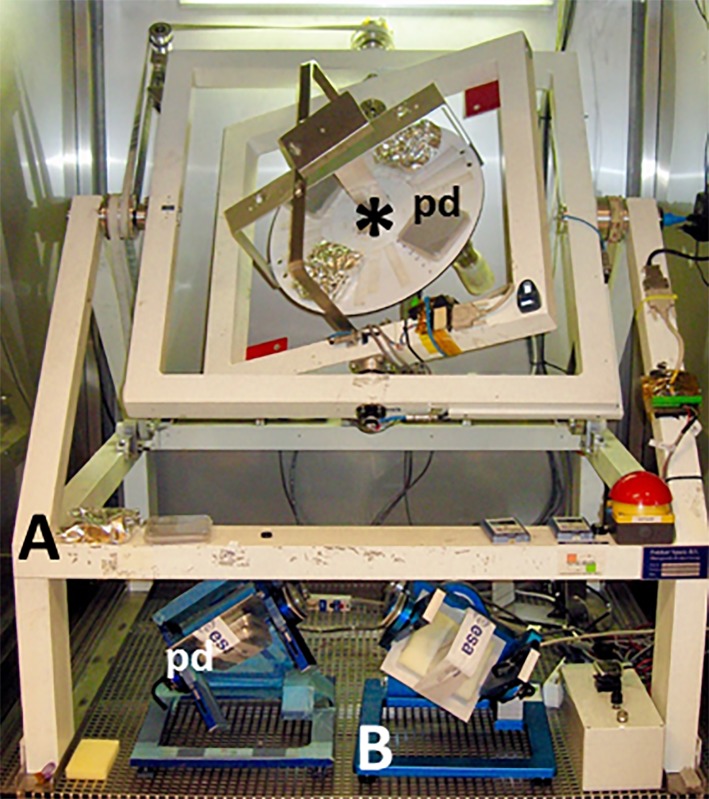
Three random positioning machines (RPMs) each with two independently driven perpendicular frames. The discrete rotation axes allow the implementation of slip rings to provide power and exchange data with the experiment that can be mounted onto the inner frame. Both the full-sized RPM (A) and the two desktop models (B) are shown with 10-cm square Petri dishes (pd). The diameter of the disk (asterisk) on the full-sized RPM is 40 cm and provides the generation of partial gravity.